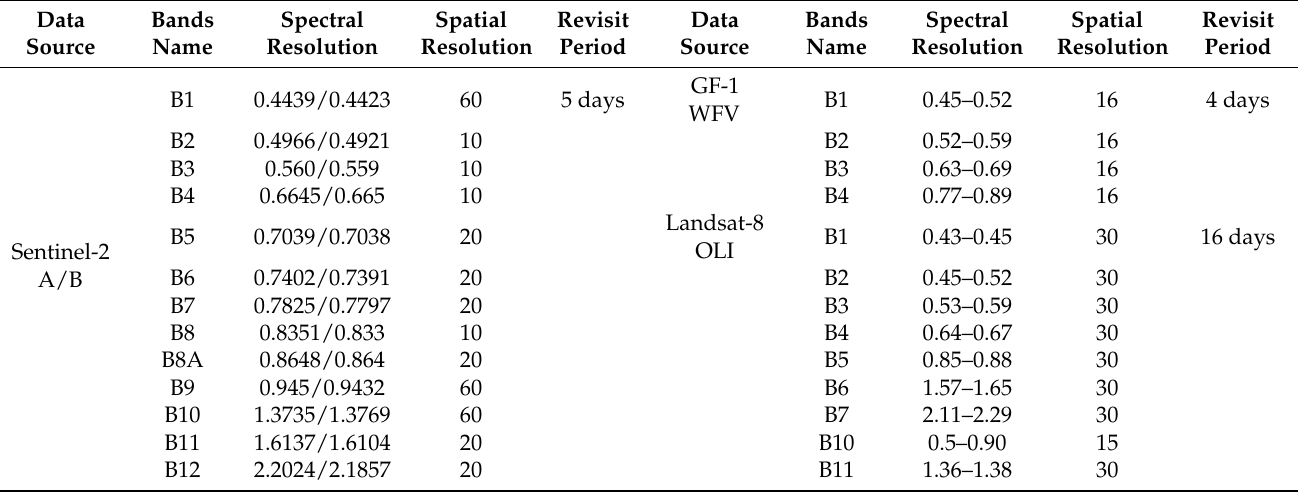
Table 1. Specific description of remote-sensing image